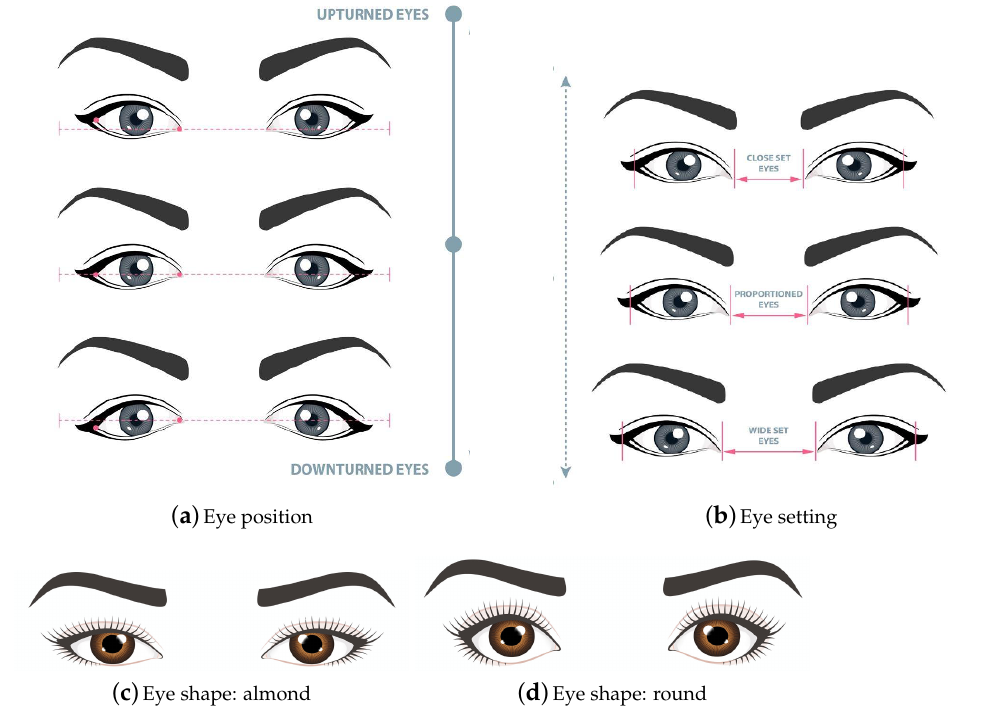
Figure 2. Eye attributes. Adapted from